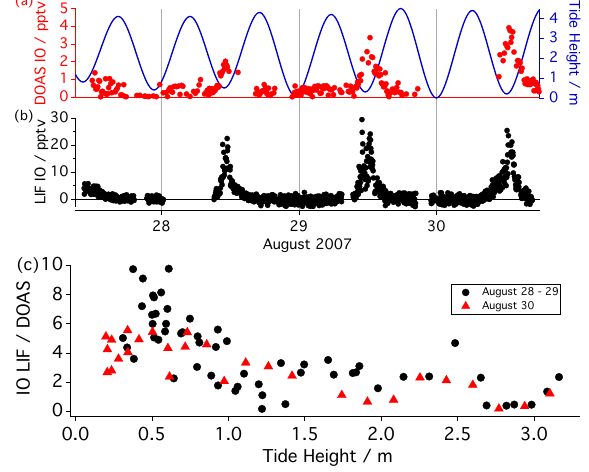
Fig. 8. Observation of LP-DOAS and LIF IO between 28–30 Au- gust. (a) LP-DOAS IO (pptv, red, 10min), tide height (blue), (b) LIF IO (pptv, black, 1min), (c) anti-correlation of the LIF/LP- DOAS IO ratio with tide height down to 0.3m. 30 August (red triangles) shows a lower ratio than 28–29 August (black dots). This corresponds to increased IO detected by the LP-DOAS on 30 Au-